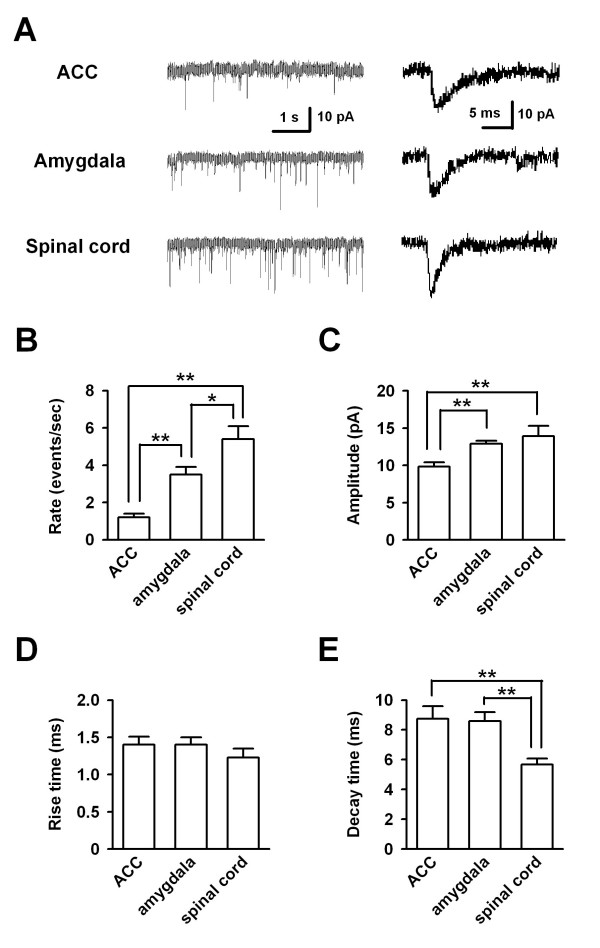
Characteristics of mEPSCs in ACC, basolateral amygdala, and spinal cord. A, Representative mEPSCs recorded at a holding potential of -70 mV from ACC, basolateral amygdala, and spinal cord neurons, respectively (left). Individual mEPSCs obtained from respective recordings (right). B-E, Bar graphs showing the averaged rate (B), amplitude (C), rise time (D), and decay time (E) in ACC (n = 12), basolateral amygdala (n = 14), and spinal cord neurons (n = 12), respectively. Note that the rate and amplitude of mEPSCs from ACC neurons are significantly lower than those from amygdala and spinal cord neurons. Also note that the decay time of mEPSCs from spinal cord neurons is significantly smaller than those from ACC and amygdala neurons. *p < 0.05, **p < 0.01.